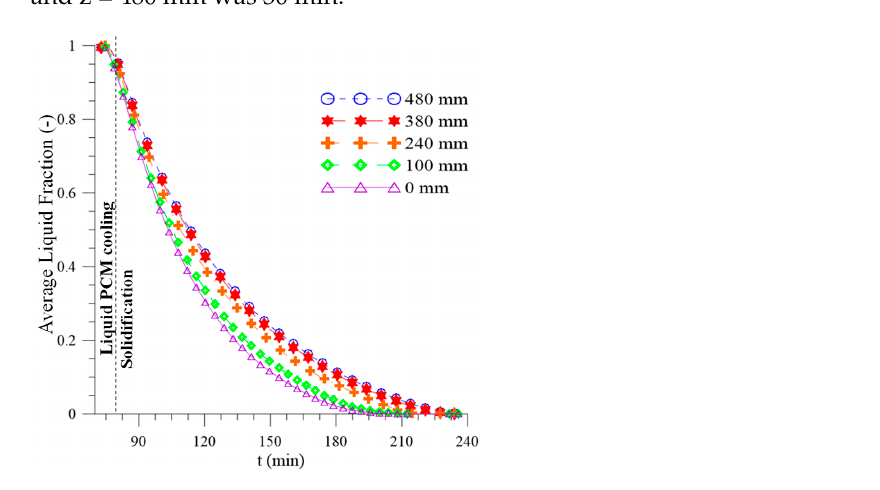
Figure 29. Average liquid fraction for different PCM sections throughout the solidification process.